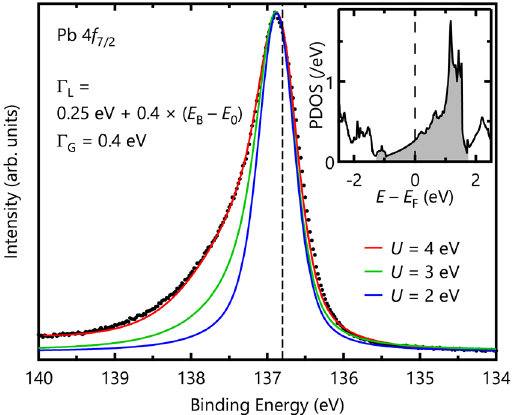
Figure 5. Pb 4 f 7/2 core-level spectrum and fitting results of MND-model calculations with the Pb 6 s partial DOS. The spectrum is well explained with U = 4 eV. The dashed line represents the lowest binding energy of 136.8 eV. The inset shows the Pb 6 s partial DOS from LDA calculations, and the gray shaded region was considered in our